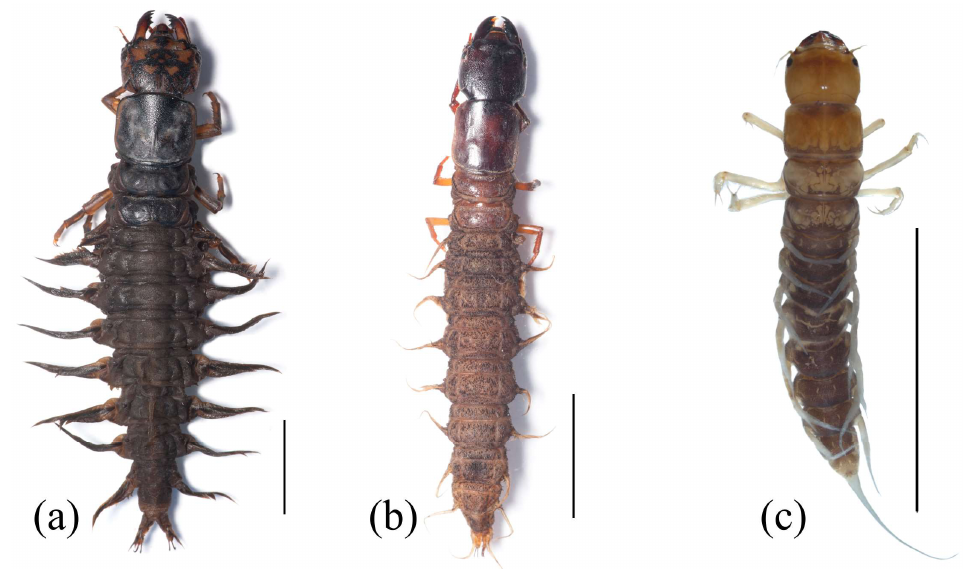
Figure 1. Habitus of Megaloptera larvae. ( a ) Corydalus liui Ardila-Camacho & Contreras-Ramos, 2018,